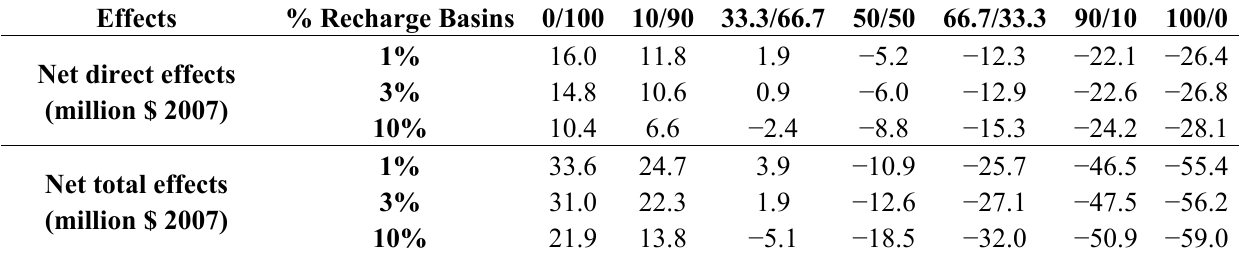
Table 9. Direct and total effects of Table 6 scenarios on labor income of a 1000 m land use